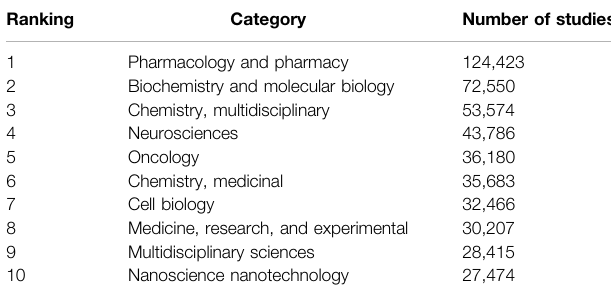
TABLE2| Top10WOSsubjectcategoriesintermsofthenumberofstudiesciting the high-impact studies in pharmacology and pharmacy